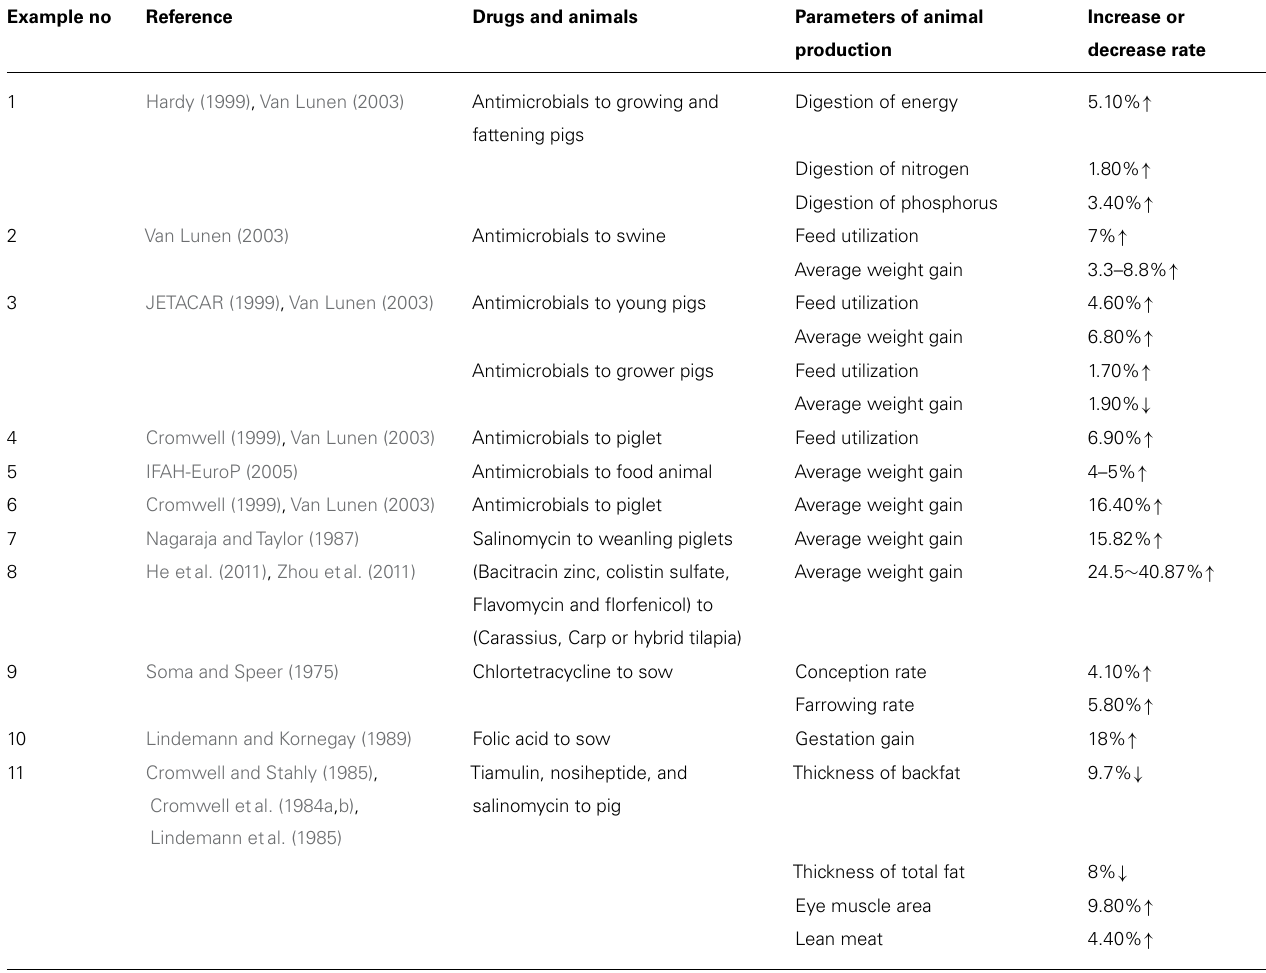
Table 1 | Part of evidences for the role of antimicrobials on feed utilization, growth promotion, reproductive performance, and carcass quality. Example